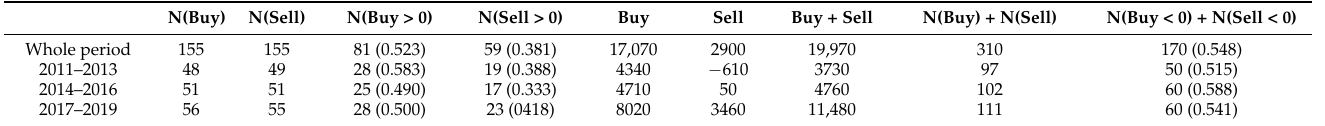
Table 3. The Performance of the MACD (4,22,3) Model with the 1-day Minimum Holding